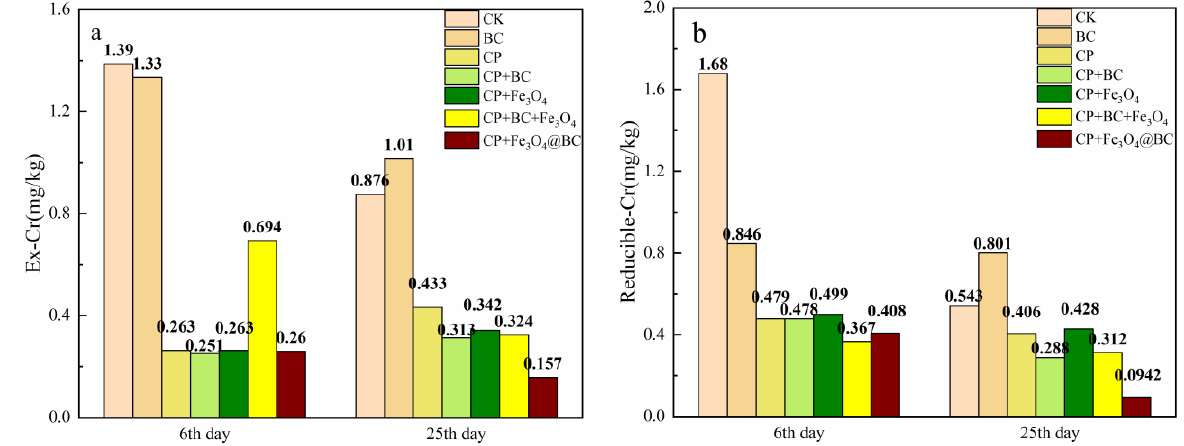
Figure 11. ( a ) The Ex-Cr fraction changes on the 6th day and the 25th day; ( b ) the reducible-Cr fraction changes on the 6th day and the 25th day.